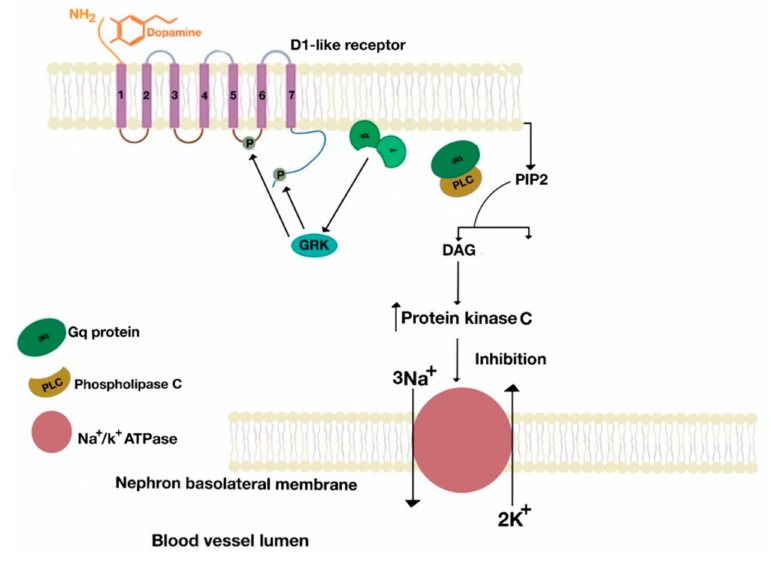
Figure 12. D1-like receptors are linked to G α q